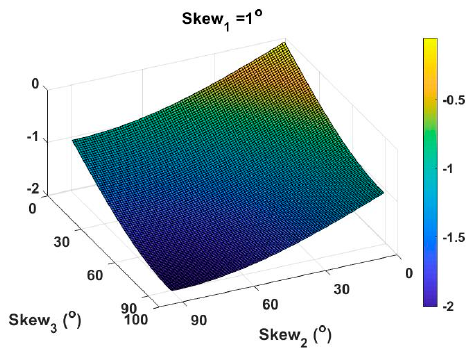
Figure 6. 3-D maximum (saturation) angular momentum on the z axis for β 1 = 1°, where β 2 and β 3 = β = free. Table 3. Maximum (saturation) yaw maneuverability skew angle combinations. | H | β 1